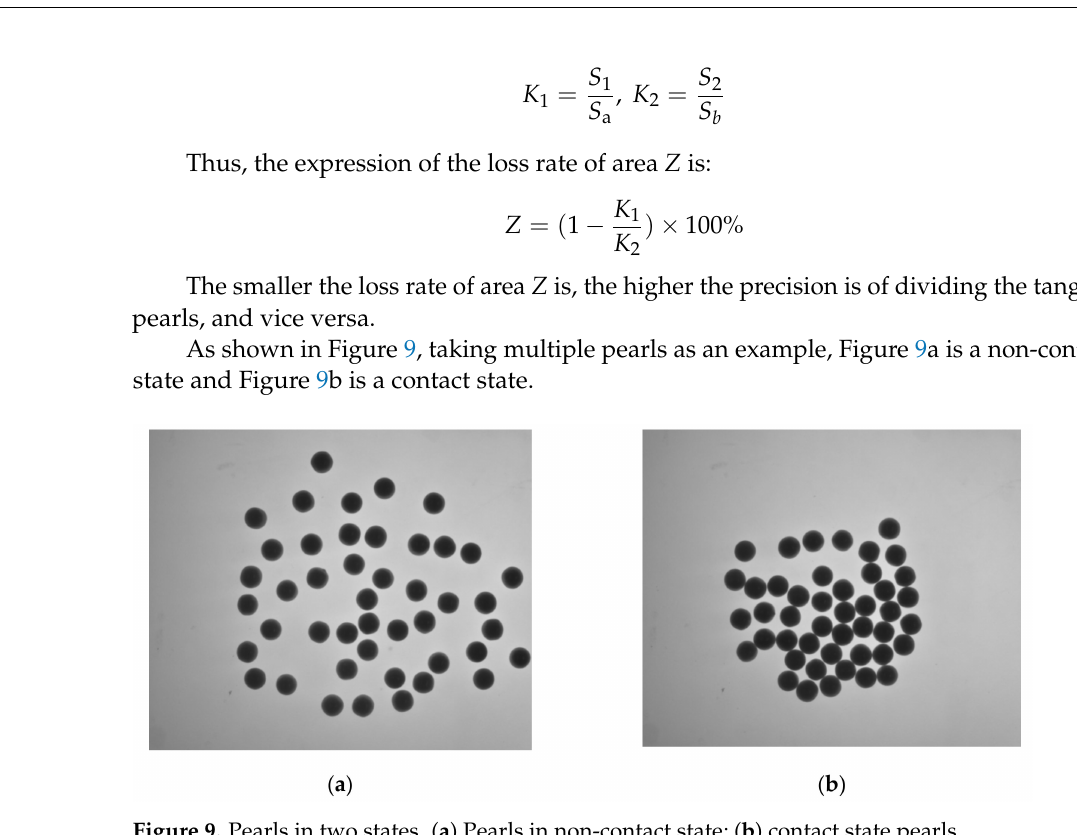
Figure 9. Pearls in two states. ( a ) Pearls in non-contact state; ( b ) contact state pearls. Based on the developed experimental platform in this paper, the watershed algo- rithm, the morphological algorithm, and the proposed method WERE compared with the experimental images. The differences of these three algorithms are discussed in Table 2. Table 2. The main differences between the three